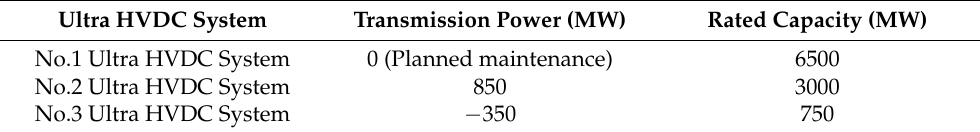
Table 1. The transmission power of Ultra HVDC System in the regional power